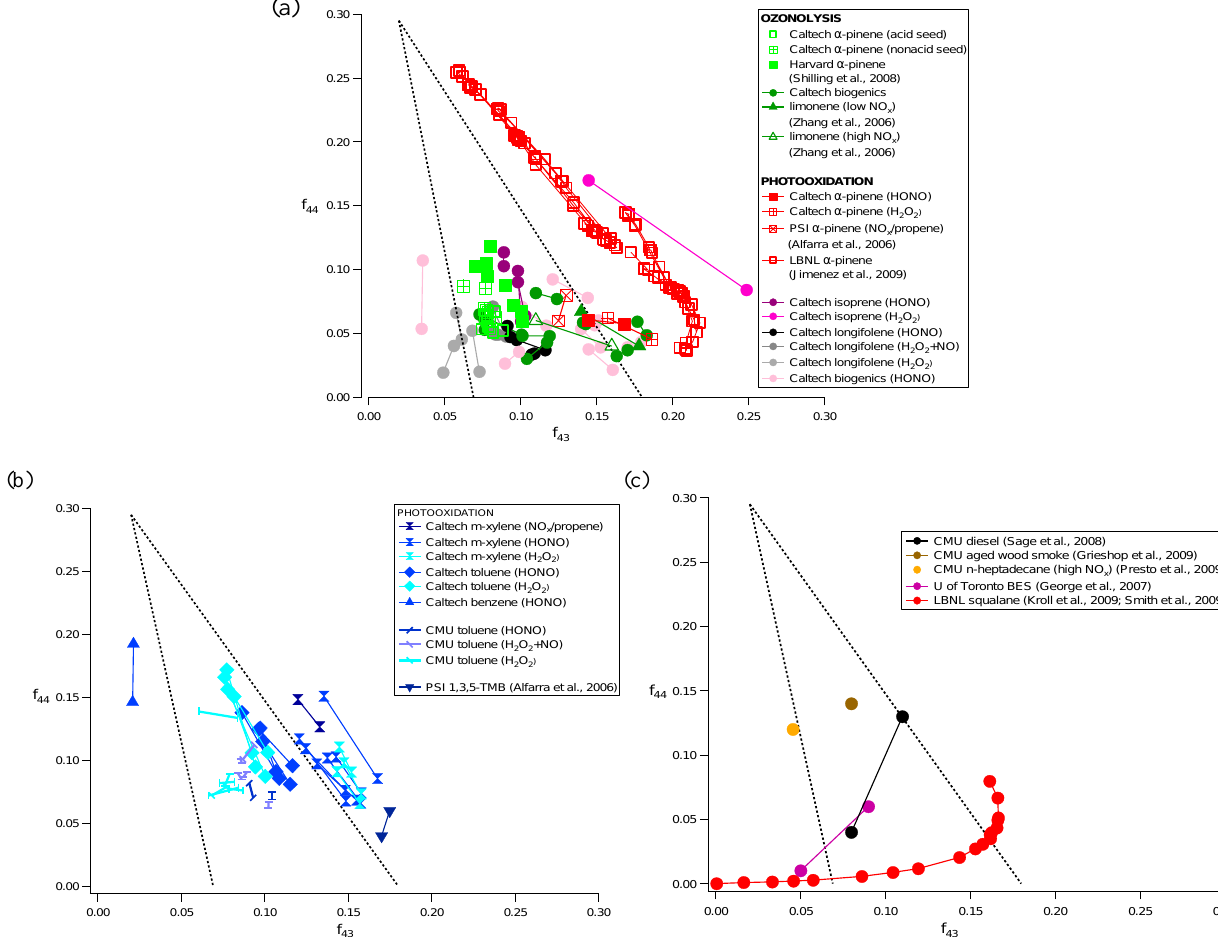
Fig. 6. (a) f 44 vs. f 43 for SOA formed by the ozonolysis/photooxidation of a suite of biogenic precursors from chamber experiments, including isoprene, terpenes, and sesquiterpenes (Gao et al., 2004a, b; Bahreini et al., 2005; Kroll et al., 2006; Lee et al., 2006a, b; Ng et al., 2006; Ng et al., 2007a). Also shown in this figure are flow tube data of the heterogeneous oxidation (by OH radicals) of SOA formed from α -pinene ozonolysis (LBNL data). The lines connecting the data points indicate the range of f 44 and f 43 observed in each experiment. For α -pinene ozonolysis, only the values at the end of the experiment are shown to avoid crowding the plot. The two dotted lines are the same as those in Fig. 4. (b) Chamber data from the photooxidation of a series of aromatic hydrocarbons, including m -xlyene, toluene, benzene, and 1,3,5-trimethylbenzene (Ng et al., 2007b; Hildebrandt et al., 2009). The lines connecting the data points indicate the range of f 44 and f 43 observed in each experiment. The two dotted lines are the same as those in Fig. 4. (c) Chamber and flow tube data from the photooxidation/heterogeneous oxidation of POA. The LBNL squalane data and CMU n-heptadecane data are HR data (the m/z 43 data shown are from the C 2 H 3 O + fragment). For diesel and wood smoke (Sage et al., 2008; Grieshop et al., 2009), the data shown here are from the residual mass spectra (i.e. spectra in which the POA contribution has been excluded). The LBNL squalane data starts from zero because the experiment starts with HOA. The two dotted lines are the same as those in Fig. 4.